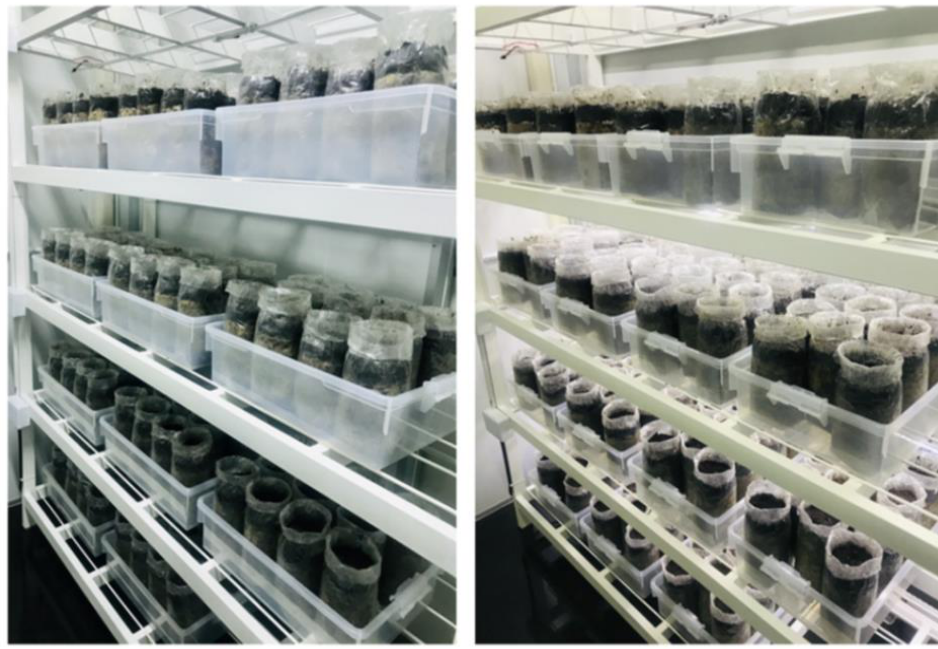
Figure 3. Cultivation of P. spongiosus in the cropping room. Table 2. Cultivation of P. spongiosus and high-voltage pulsed stimulation.